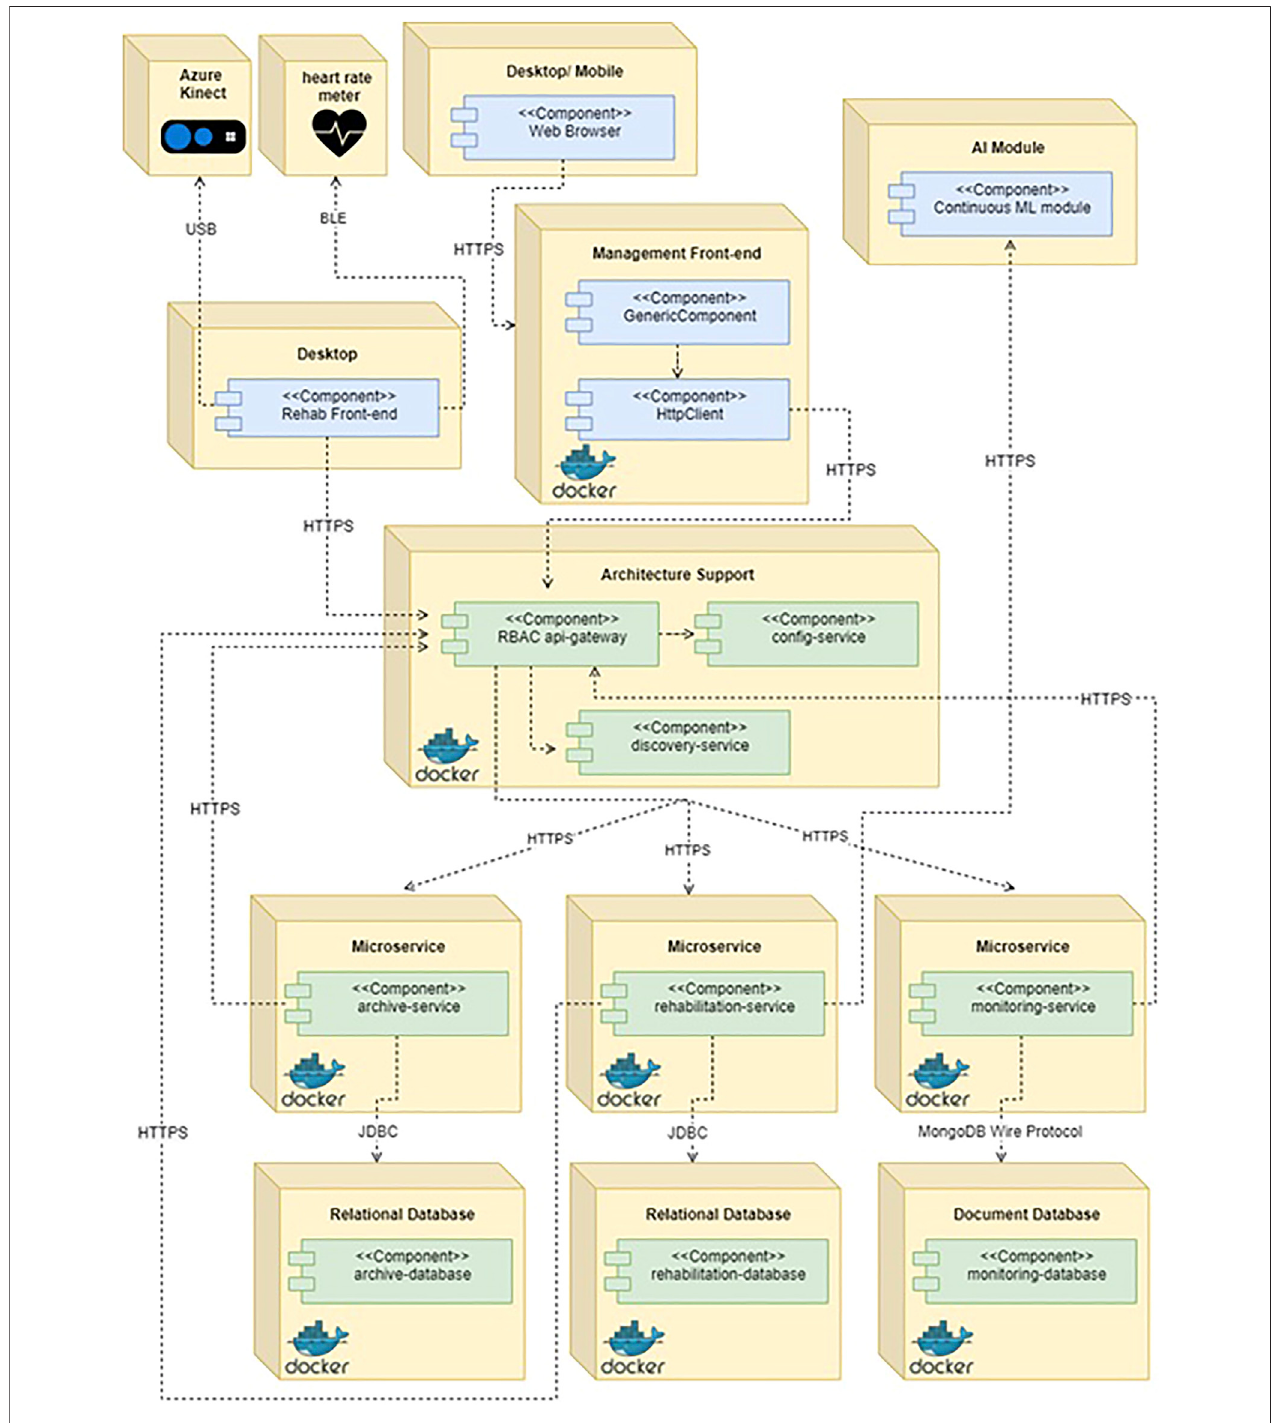
FIGURE 3 | 2Vita-B Physical system deployment